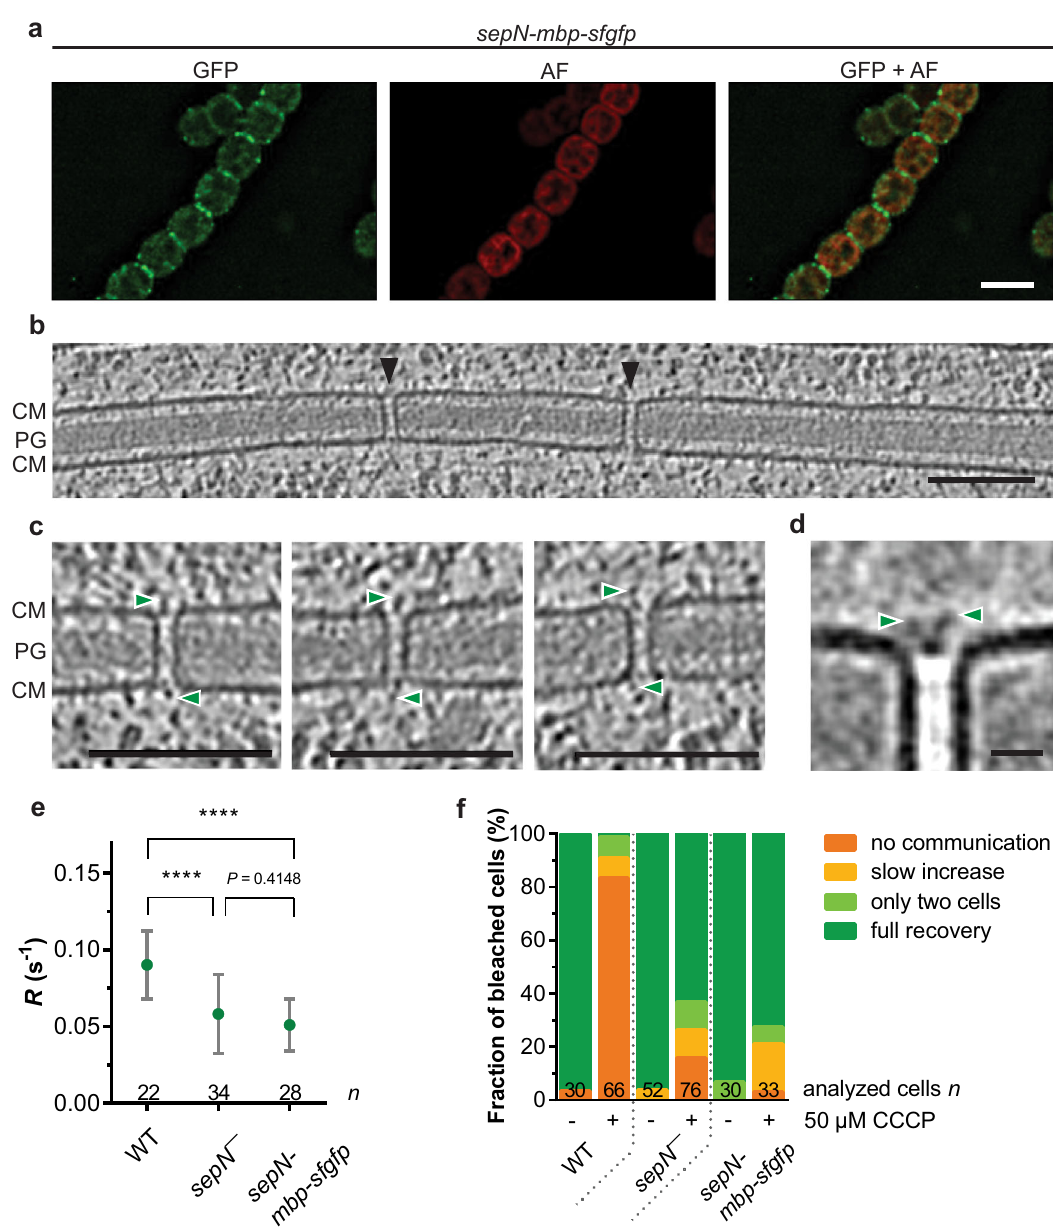
Fig. 6 | Fusion of maltose-binding protein to SepN disrupts cap assembly and impairs gating of cell – cell communication. a fLM analysis of a Nostoc fi lament expressing SepN-MBP-sfGFP reveals septal foci. Bar, 5 µ m. GFP, gfp channel;